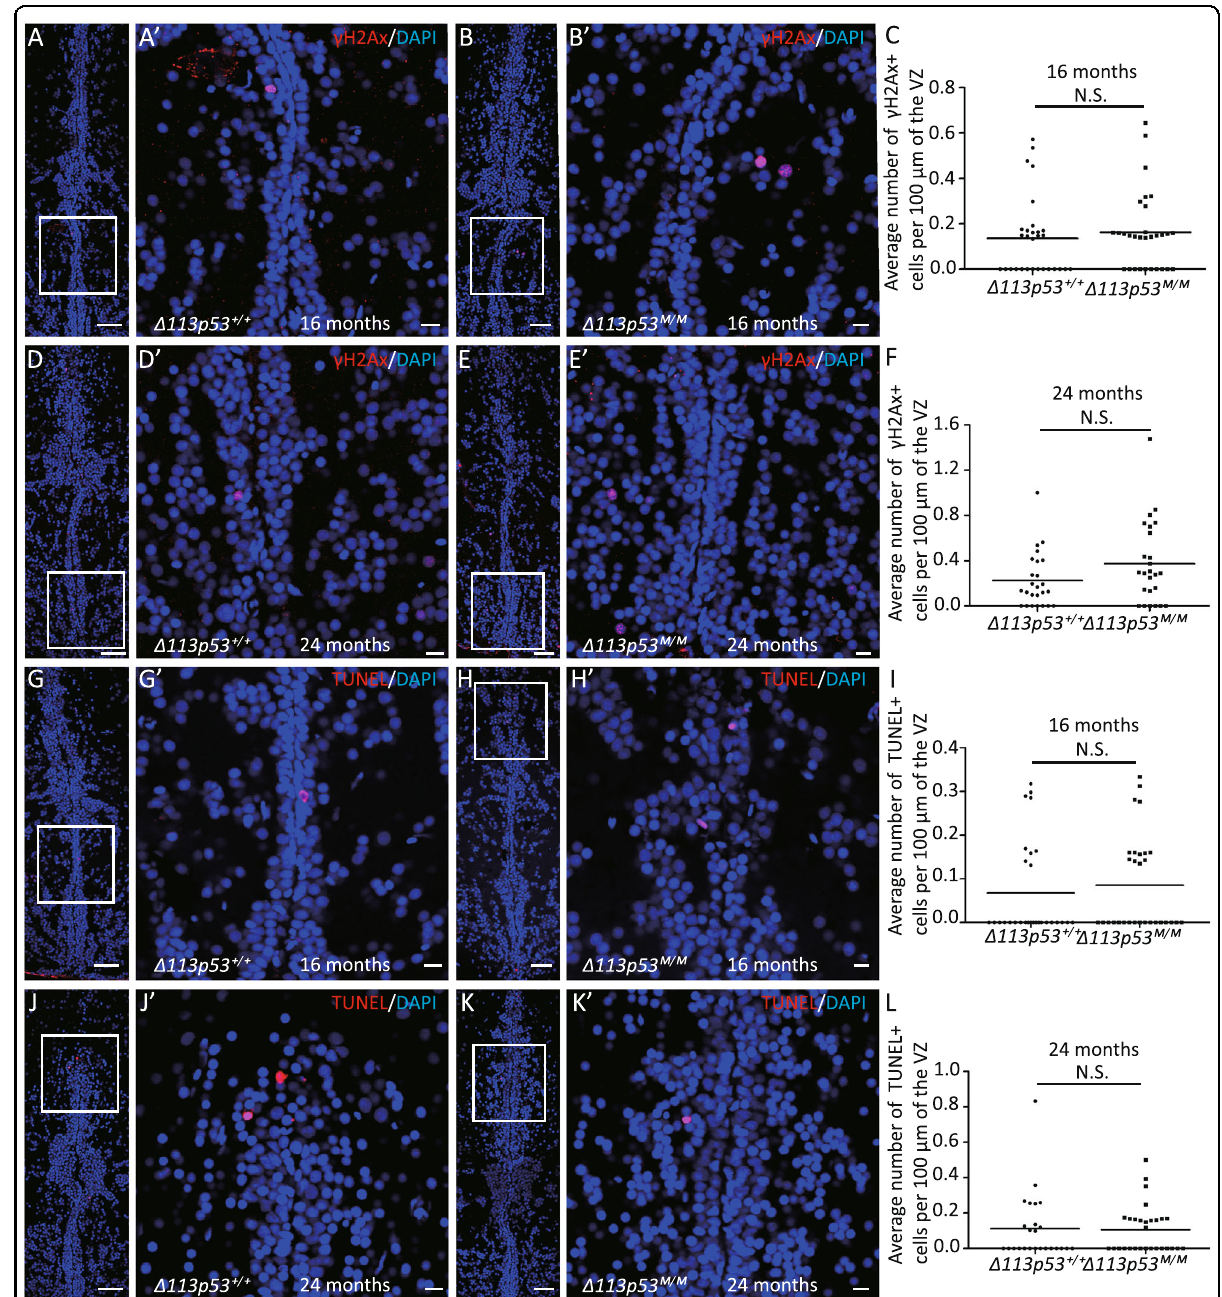
Fig. 6 Depletion of Δ 113p53 has little effect on DNA damage response and apoptotic activity in zebra fi sh telencephalons. A – F Cryosections of Δ 113p53 + / + ( A , D ) and Δ 113p53 M/M telencephalons ( B , E ) at 16- or 24-months old were stained with an anti- γ -H2AX (in red) antibody. G – L TUNEL assay (in red) was performed on cryosections of Δ 113p53 + / + ( G , J ) and Δ 113p53 M/M zebra fi sh telencephalons ( H , K ) at 16- and 24-months old, as indicated. The nuclei were stained with DAPI (in blue). An average number of γ -H2AX + cells or apoptotic cells per 100 μ m of the ventricular zone (VZ) in one section from the middle region of each telencephalon was presented in C (16-months old) and F (24-months old) or I (16-months old) and L (24-months old), respectively. Framed areas in A , B , D , E , G , H , J , K were magni fi ed in A ’ , B ’ , D ’ , E ’ , G ’ , H ’ , J ’ , K ’ , respectively. Scale bar in A , B , D , E , G , H , J , K , 50 μ m; Scale bar in A ’ , B ’ , D ’ , E ’ , G ’ , H ’ , J ’ , K ’ , 10 μ m. Each dot represents the average number of γ -H2AX + cells or apoptotic cells per 100 μ m of VZ in one section. About four to fi ve sections were chosen from the middle region of each telencephalon, and at least fi ve telencephalons were sampled in each group. Statistical analysis was performed on relevant data using the Student ’ s two-tailed t test. N.S., P >